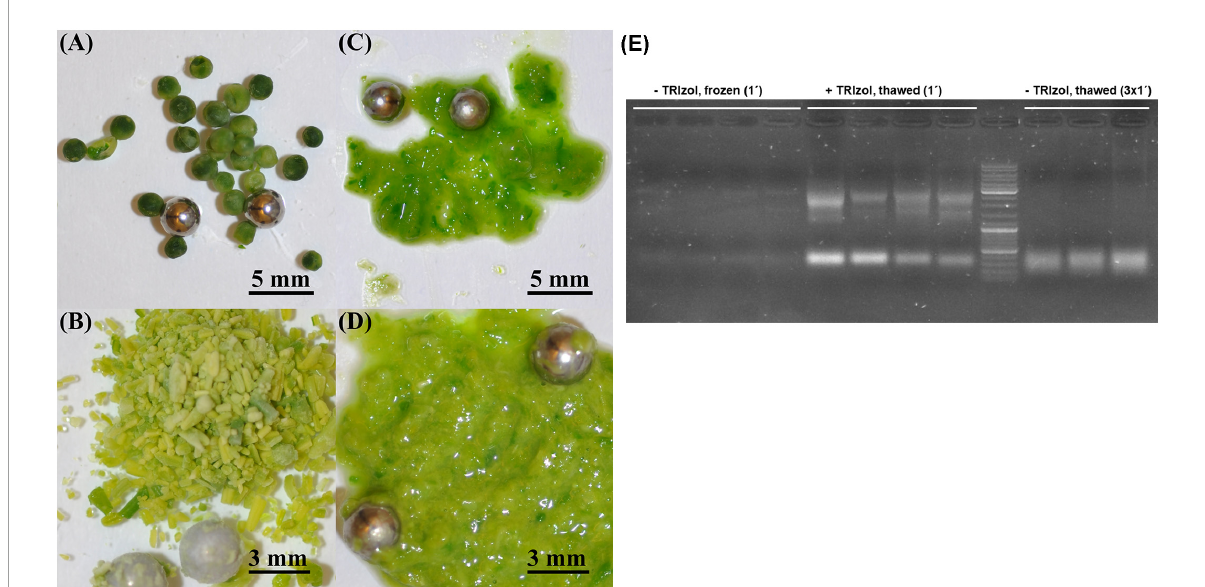
FIGURE1 Comparison of different homogenization strategies in young seeds and buds. (A) Young seeds without TRIzol addition, (B) buds without TRIzol addition, (C) young seeds with addition of 100 µ l TRIzol before homogenization, (D) buds with addition of 100 µ l TRIzol before homogenization, (E) Impact of homogenization strategy on RNA integrity. Marker—Invitrogen gene ruler 1 kb + ( Cat. No. SM0311 ); left—undegraded RNA (low yield) isolated without TRIzol addition before, 1 min of homogenization of frozen plant tissue; middle—undegraded RNA (high yield) isolated with addition of 100 µ l TRIzol before, 1 min of homogenization of thawed plant tissue; right—degraded RNA (high yield) isolated without TRIzol addition before, 3 × 1 min of homogenization in order to reach comparable tissue disruption efficiency in comparison with + TRIzol